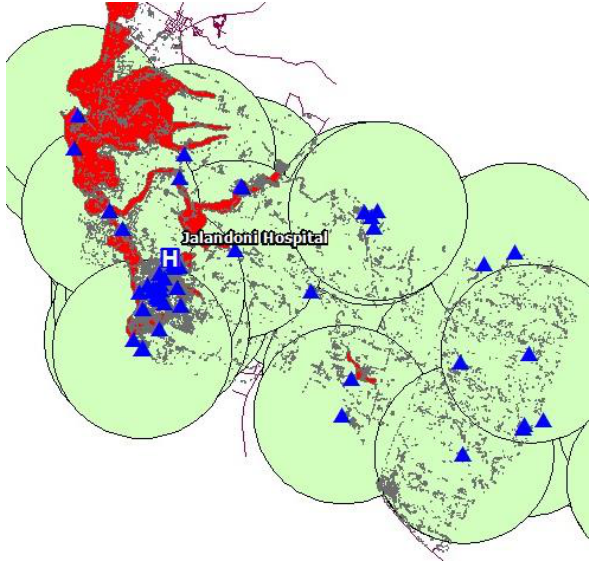
Figure 8. Most buildings are within 3km radius of a facility